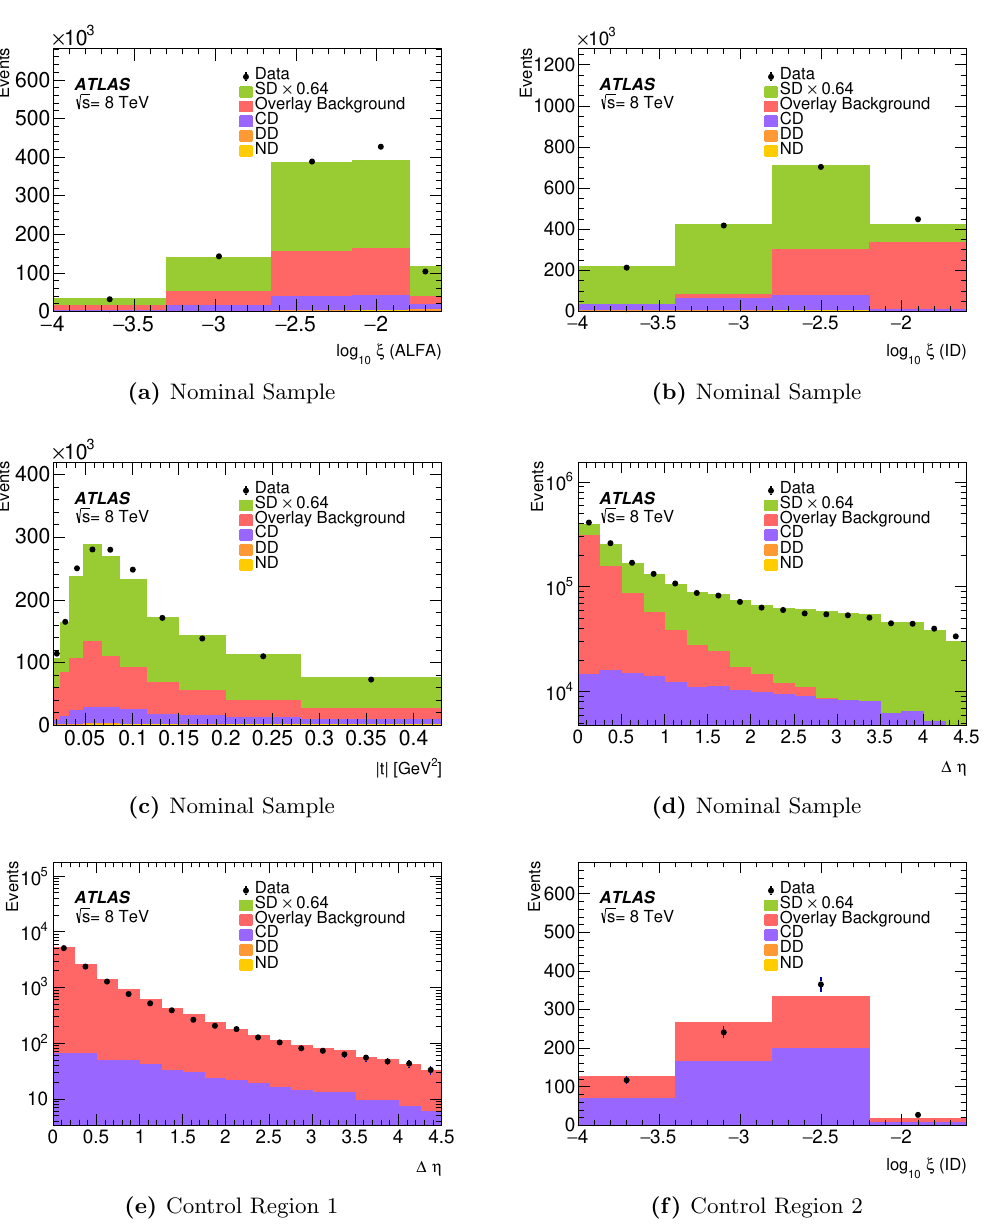
Figure 2. Uncorrected (i.e. detector level) distributions of (a) log (cid:24) measured in ALFA, (b) log (cid:24) 10 10 mesaured in the ID, (c) j t j and (d) (cid:1) (cid:17) for the basic selection of the measurement. (e) Uncorrected (cid:1) (cid:17) distribution from Control Region 1, in which two proton track segments are required rather than one. (f) Uncorrected distribution in log (cid:24) measured in the ID for Control Region 2, in 10 which exactly two proton track segments are required and the MBTS multiplicity is required to be between 2 and 10. In all distributions, data are compared with the sum of the overlay background model and the Pythia 8 A3 tune prediction with the SD contribution scaled by 0.64 to match the measurement in this paper. In (f), the CD (cid:24) distribution at the MC generator level is reweighted as described in the text. Signi(cid:12)cant contributions in (a) beyond the log (cid:24) range of the measurement 10 are not shown. The uncertainties shown are